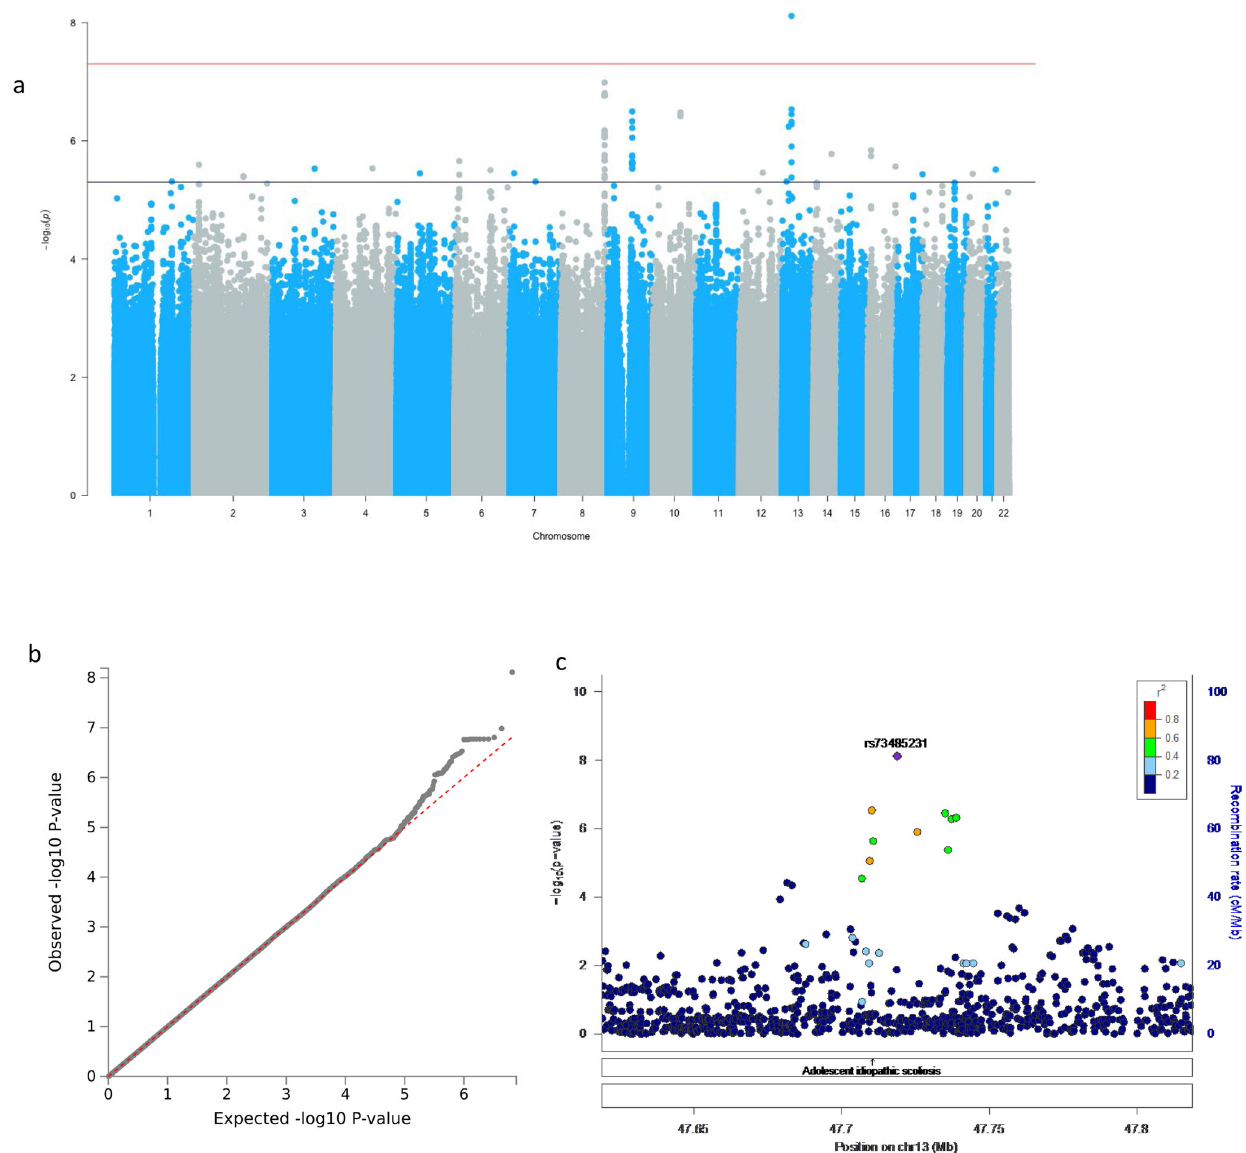
Fig. 1 Genome-wide and suggestive associations with verbal episodic memory. a Manhattan plot. Genome-wide signi fi cance cut-off 5 × 10 − 8 is shown by red line and suggestive cut-off 5 × 10 − 6 is shown by blue line. b QQ-plot ( λ = 0.99) for association summary statistics c Locus zoom plot for rs73485231. LD is based on a South African LD